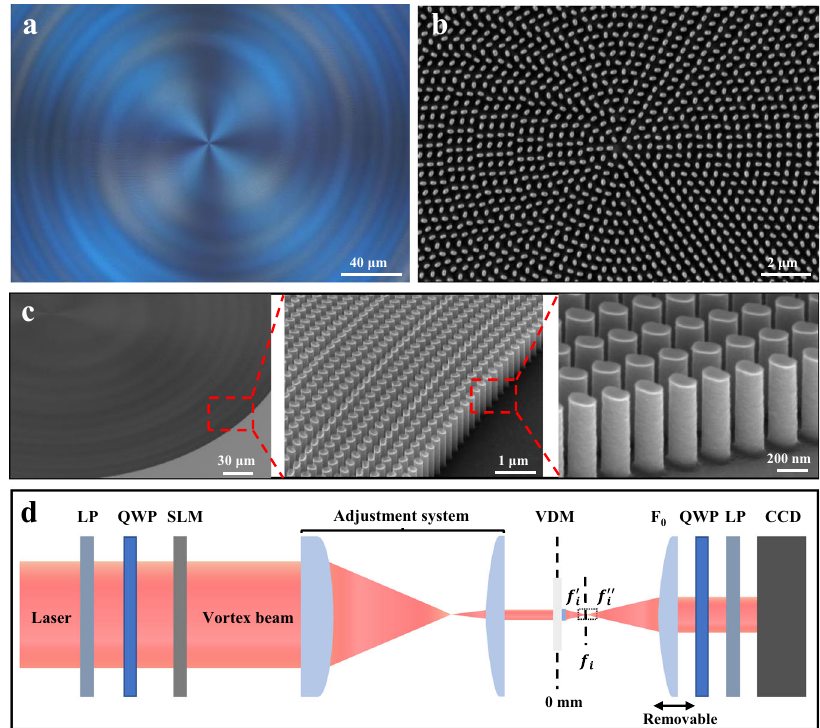
Fig. 3 | Fabricated devices and experimental setup. a Top view optical photo of theVDMcenter. b DetailedplanformSEMimageoftheVDMcenter. c Con fi guration SEM images of the nano fi ns array at the margin of the VDM with increasing the